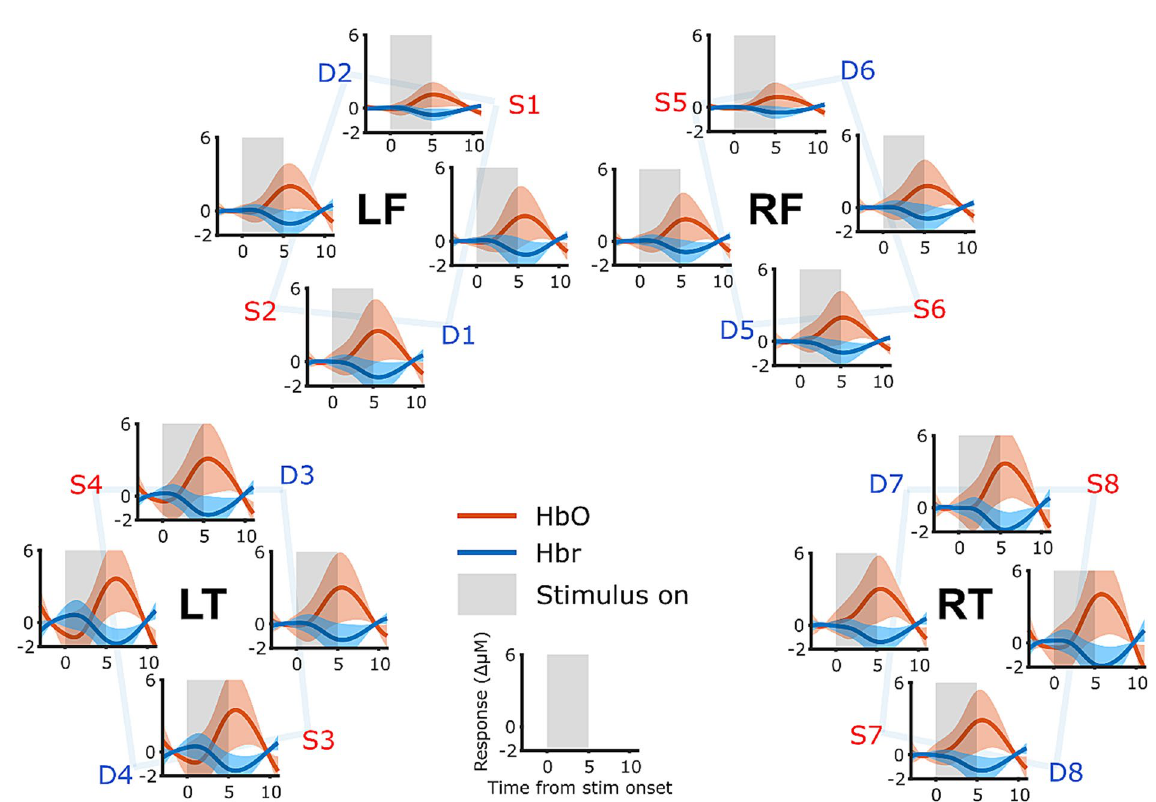
Figure 5. Grand average responses acquired at each recording channel. Each source and detector is indicated by red and blue text (S1–S8, D1–D8) respectively. Grey bars show when the sound stimulus was presented (five seconds duration), and shaded bars show one standard deviation across participants. Each region of interest is indicated in black text (LF, LT, RF and RT for left prefrontal, left temporal, right prefrontal, right temporal respectively) and consists of groups of four channels in their corresponding